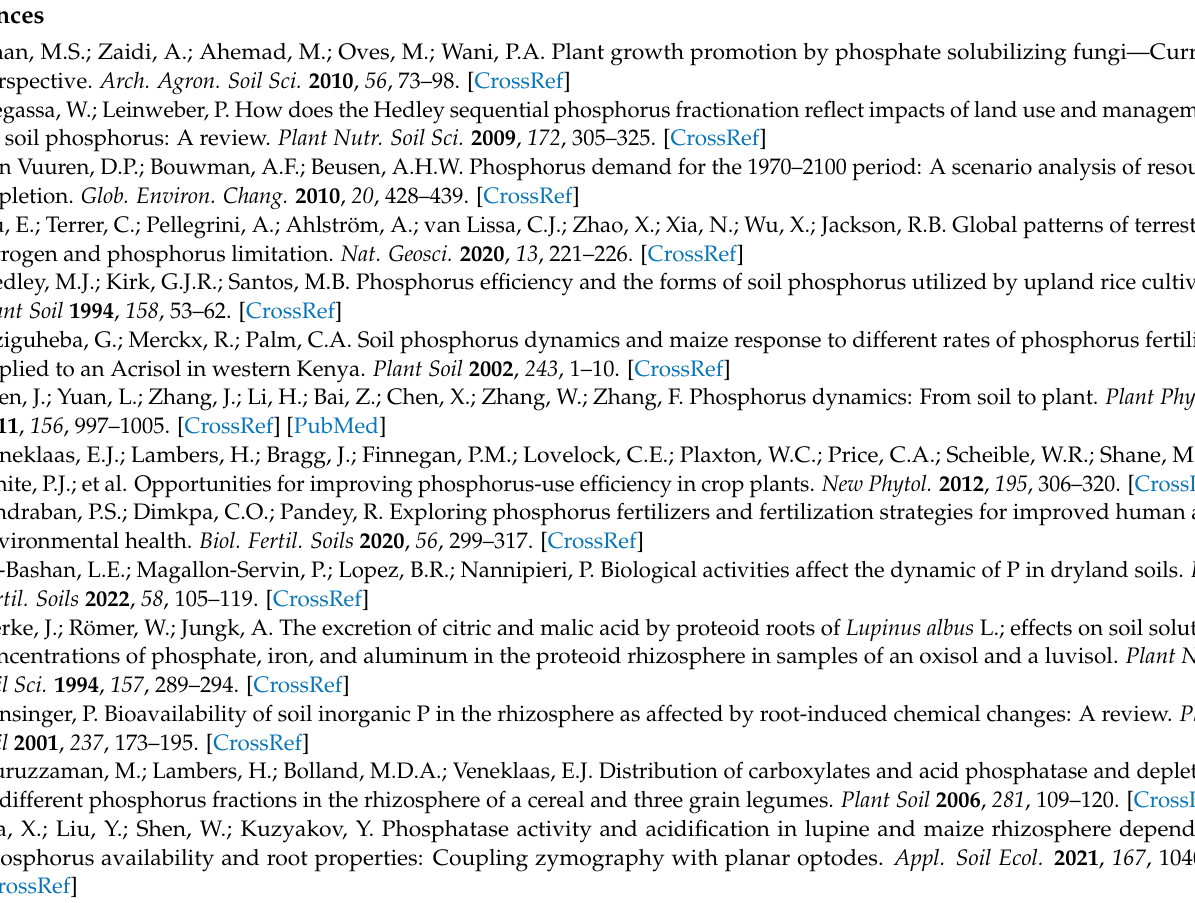
experiment; Table S3: The amount of organic acid per root; Table S4: The amount of organic acid per pot; Table S5: pH after pot